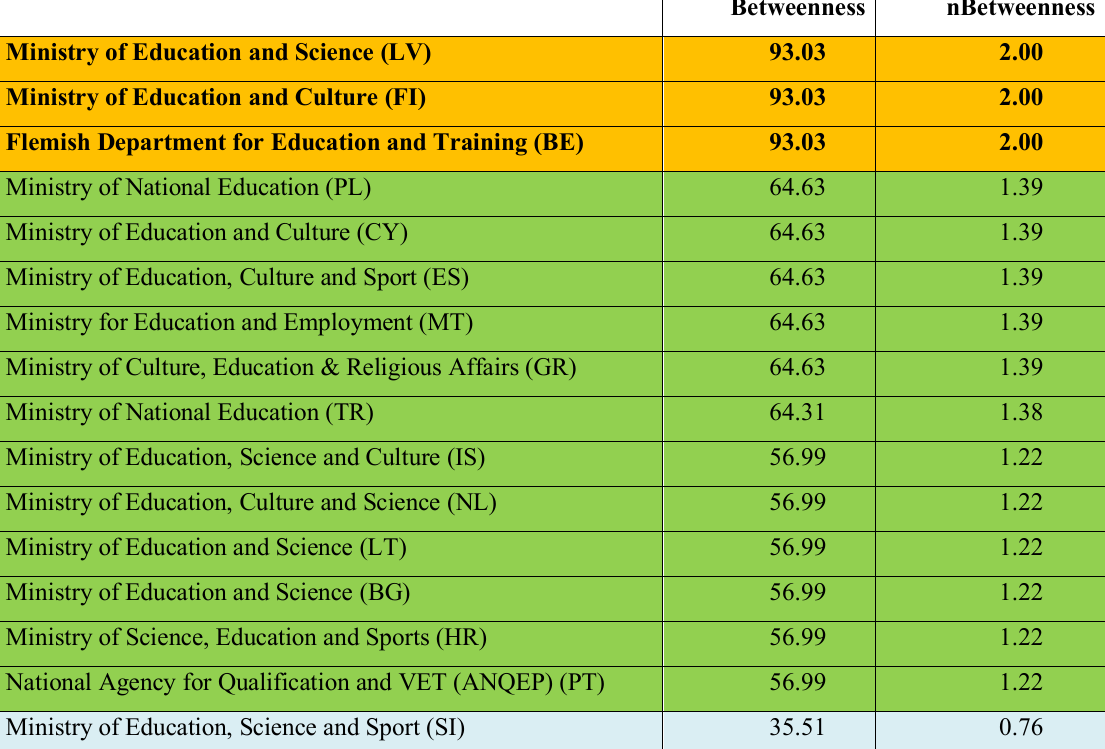
Table 3 – The level of centrality: Betweenness and nBetweenness